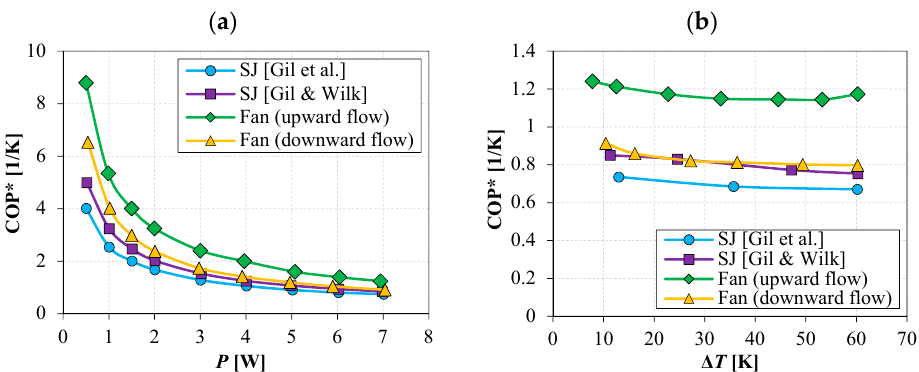
Figure 9. The COP* as a function of ( a ) the power supplied to the cooling device; ( b ) temperature difference ∆ T = ( T b − T ∞ ) at the power of P = 7.0 W. Data from: Gil et al. [27], Gil and Wilk [ Error! Reference source not found. ].